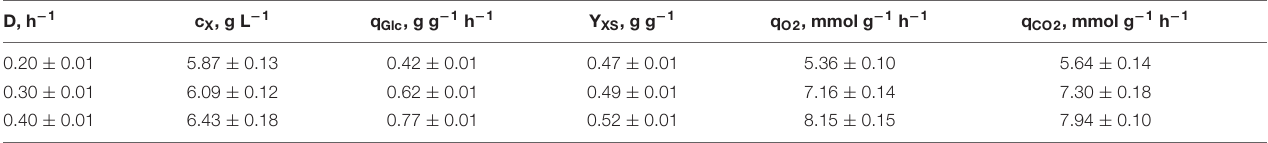
TABLE 1 | Listing of kinetic process parameters ± standard deviation calculated from three individual chemostat processes (A, B, C; Figure 1 ) with C. glutamicum cultivated in CGXII medium supplemented with (12.47 ± 0.35) g D -glucose L − 1 .